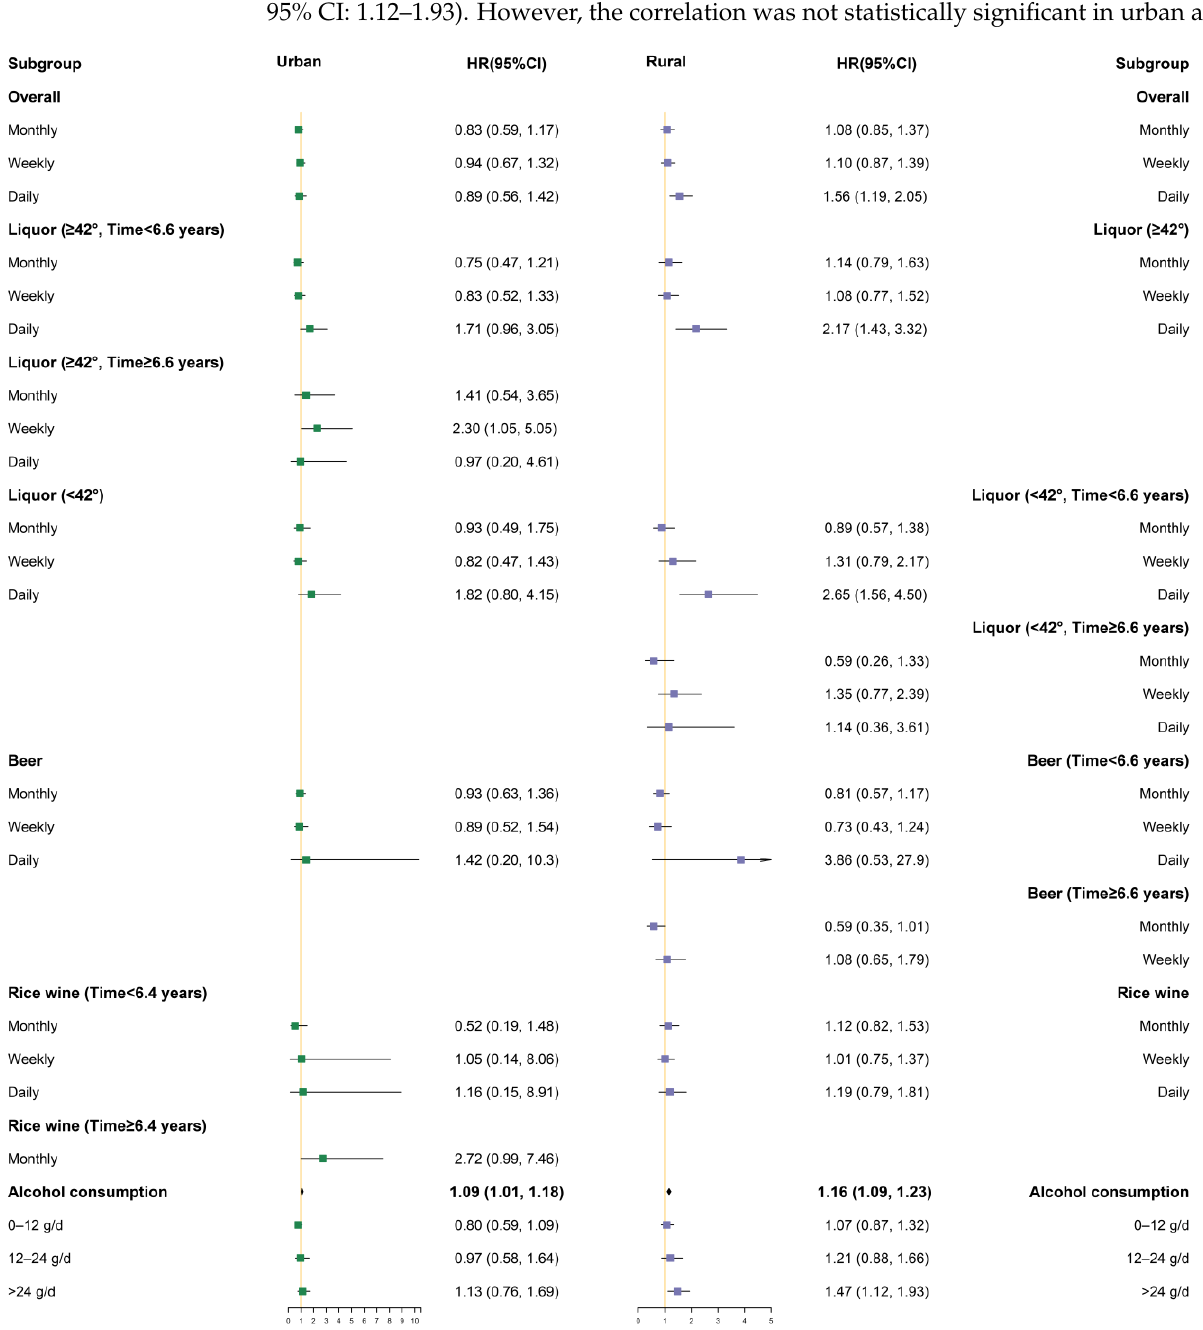
Figure 2. Subgroup analysis after stratification by urban and rural areas (Model